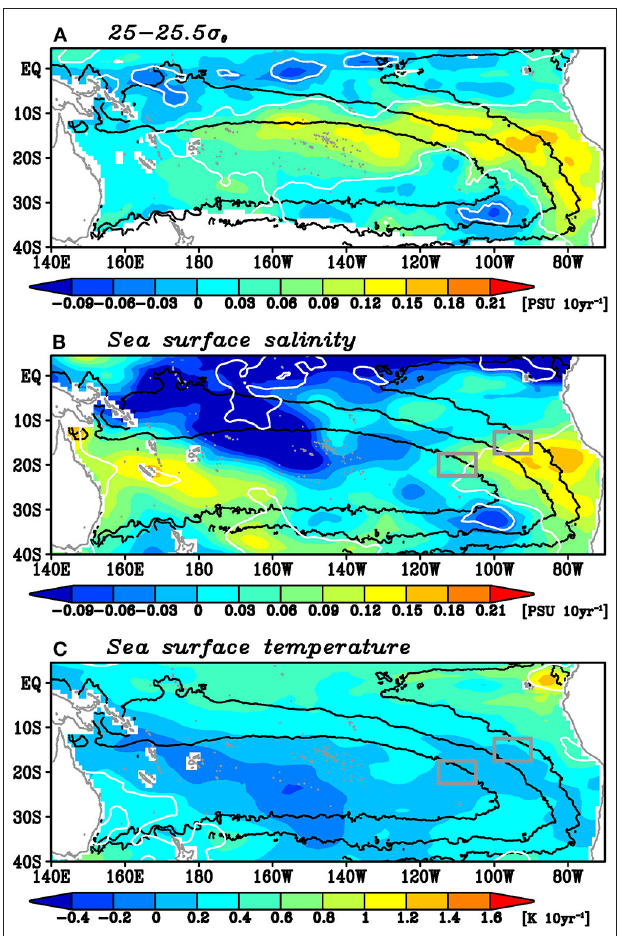
FIGURE 7 | Linear trends of (A) the salinity on the 25–25.5 σ θ isopycnals, (B) the sea surface salinity, and (C) the sea surface temperature. White contours denote the regions where the trends are significant at 90% confidence level. Black contours denote 6,000, 7,000, and 8,000kg m − 1 s − 2 isopleths of the mean Montgomery potential. The two gray boxes in (B,C) denote the region where the area-averaged salinity anomalies shown in Figure 4 are calculated.